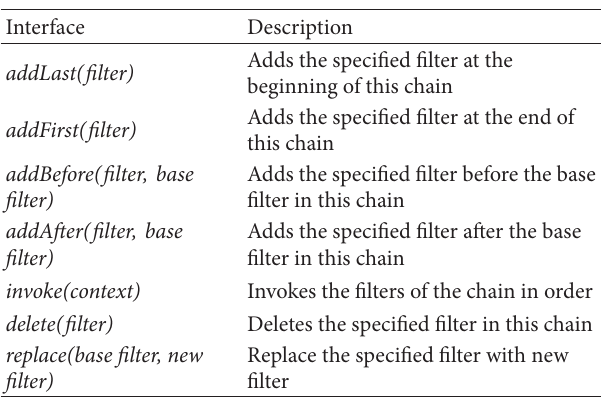
Table 2: Filter chain